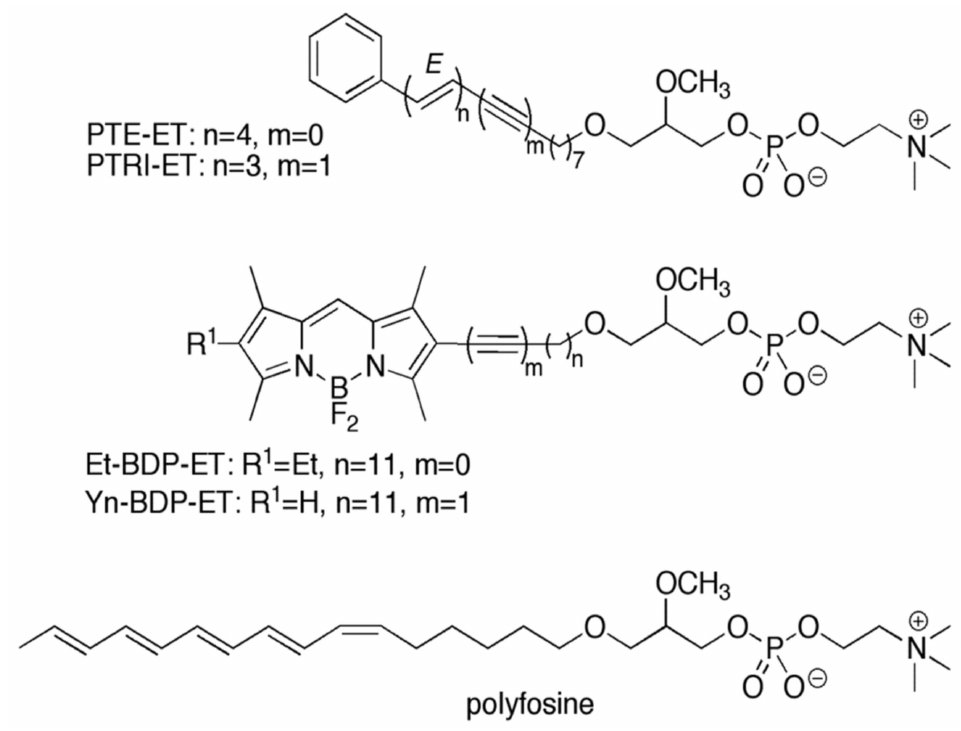
Figure 3. Chemical structures of fluorescent edelfosine